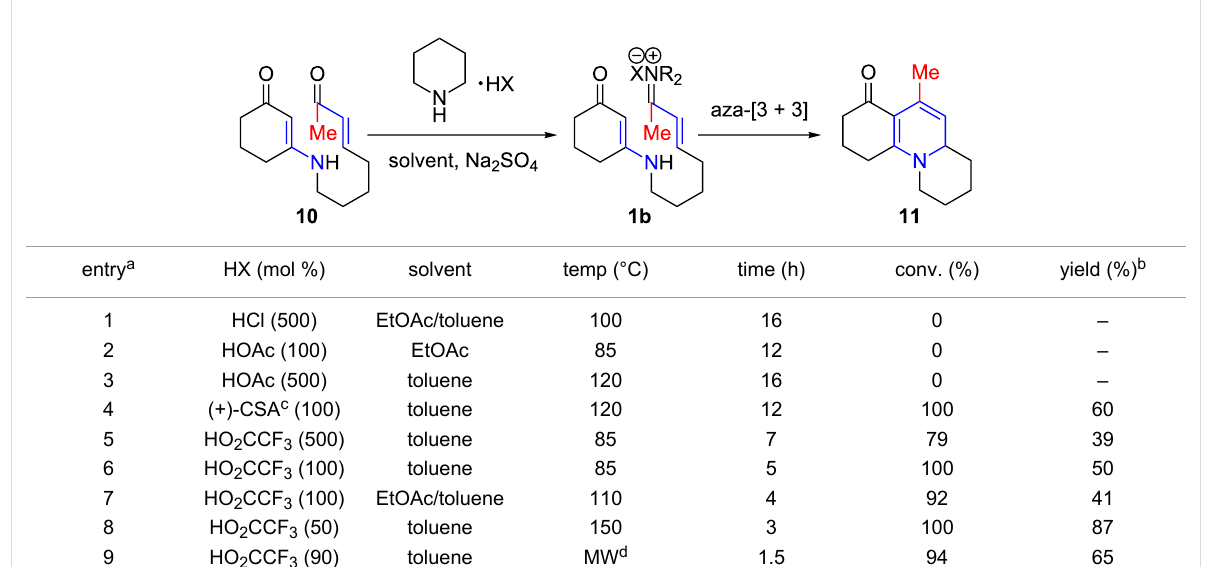
Table 1: Catalyst screening and